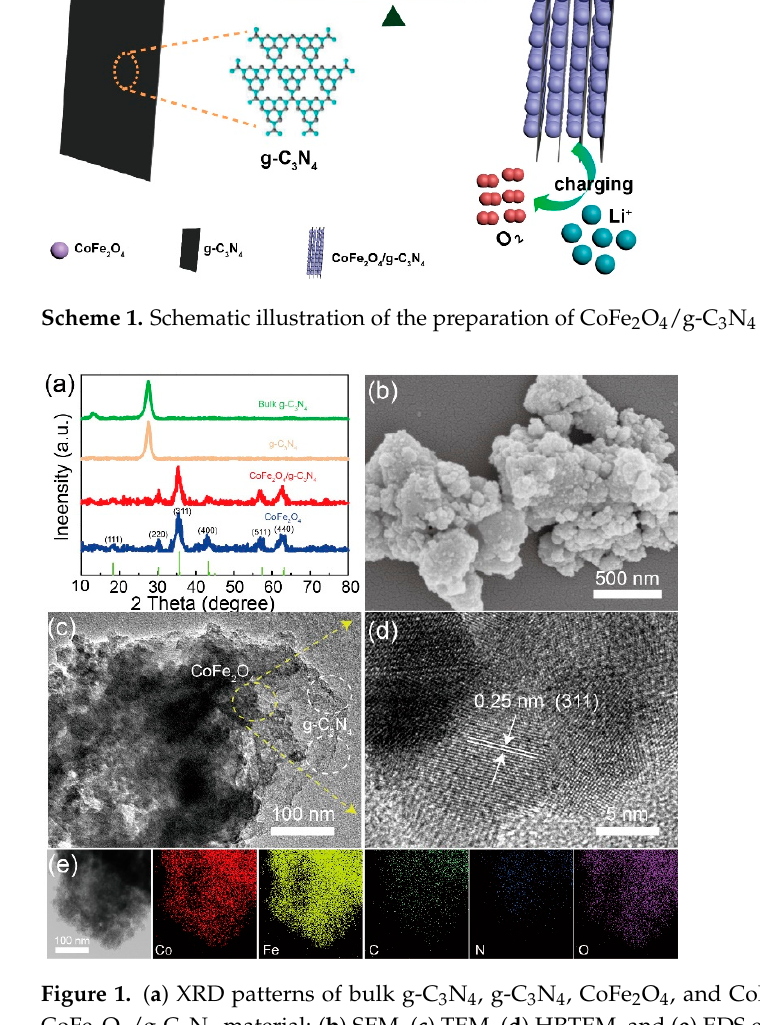
Figure 1. ( a ) XRD patterns of bulk g-C 3 N 4 , g-C 3 N 4 , CoFe 2 O 4 , and CoFe 2 O 4 /g-C 3 N 4 ; images of CoFe 2 O 4 /g-C 3 N 4 material: ( b ) SEM, ( c ) TEM, ( d ) HRTEM, and ( e ) EDS elemental mapping.